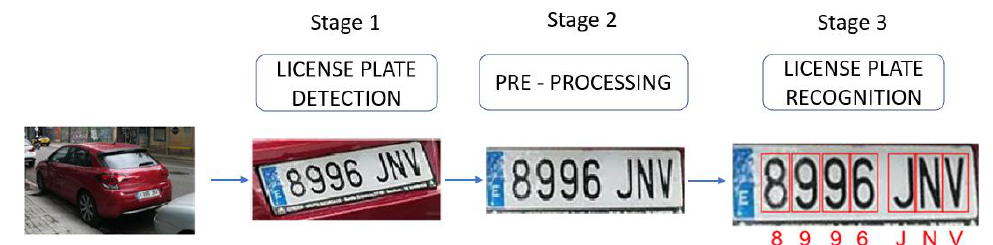
Figure 3. Representation of main stages in a multi-stage license plate recognition system.